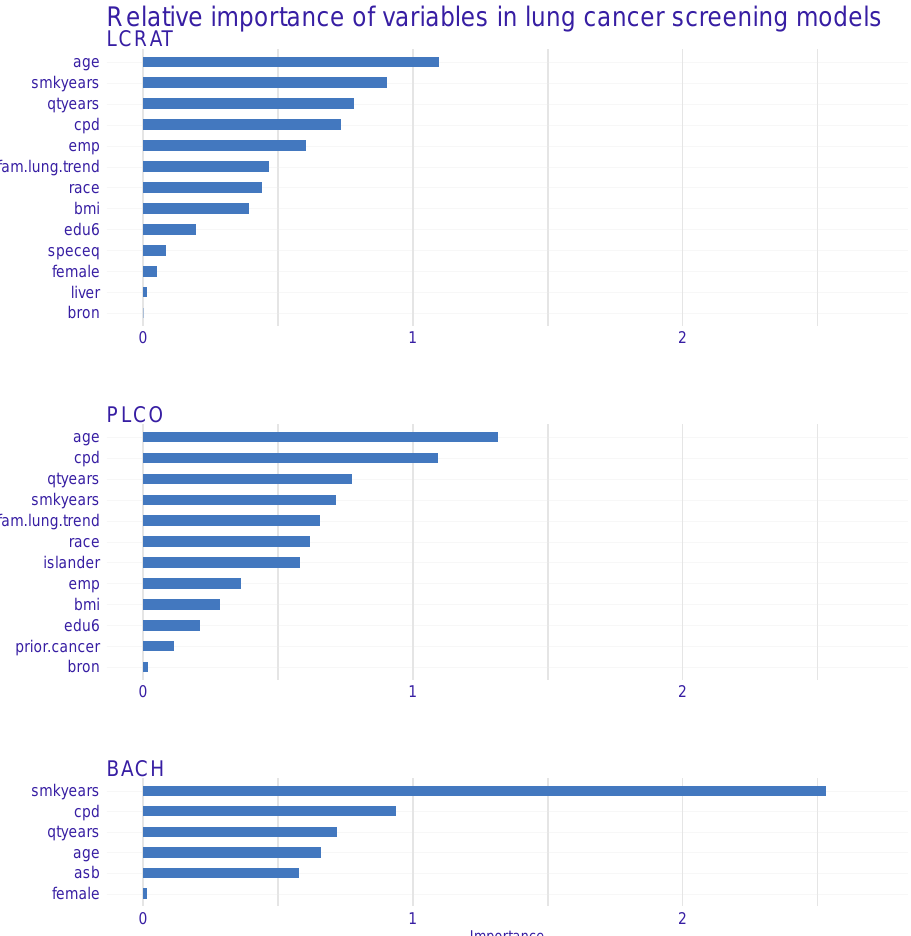
Figure 2. Variable importance for the three considered risk models. The longer the bar is, the more important the corresponding variable. Note that asb stands for asbestos exposure, cpd stands for cigarettes per day, while islander stands for Pacific Islander